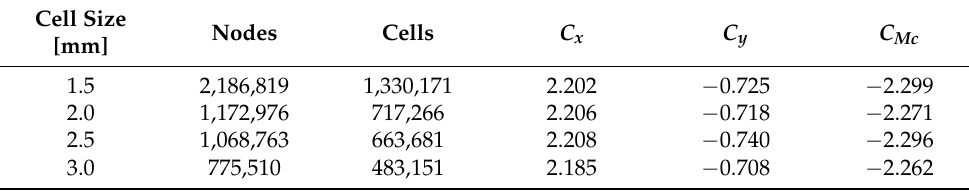
Table 5. The force and moment coefficients for different finite volume mesh. Cell Size [mm]